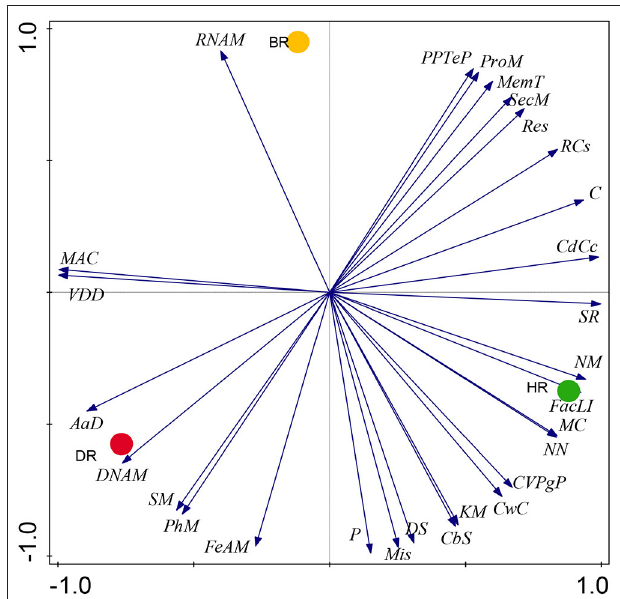
FIGURE 2 | The PCA graph showing prominent metabolism of the microbial biomes in the healthy, diseased rhizosphere soil of tomato plants and bulk soil samples at Level 1. Axis 1 (59%) and Axis 2 (41%) revealed the variations based on Euclidean differences. HR = soil obtained from healthy tomato rhizosphere, DR, rhizosphere soil from diseased tomato; BR, bulk soil.